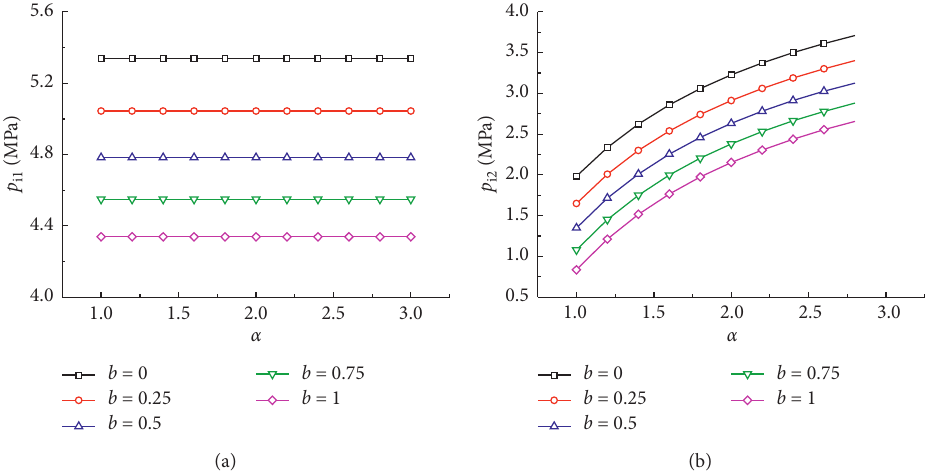
i 1 and (b) p i 2 .